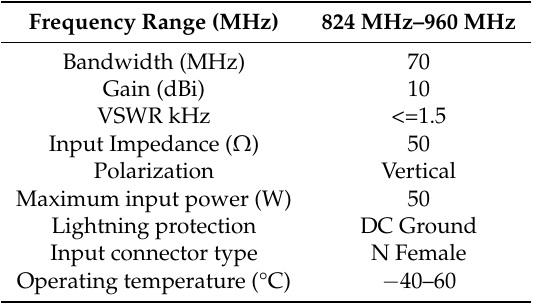
Table 2. Technical specifications of outdoor 868 MHz